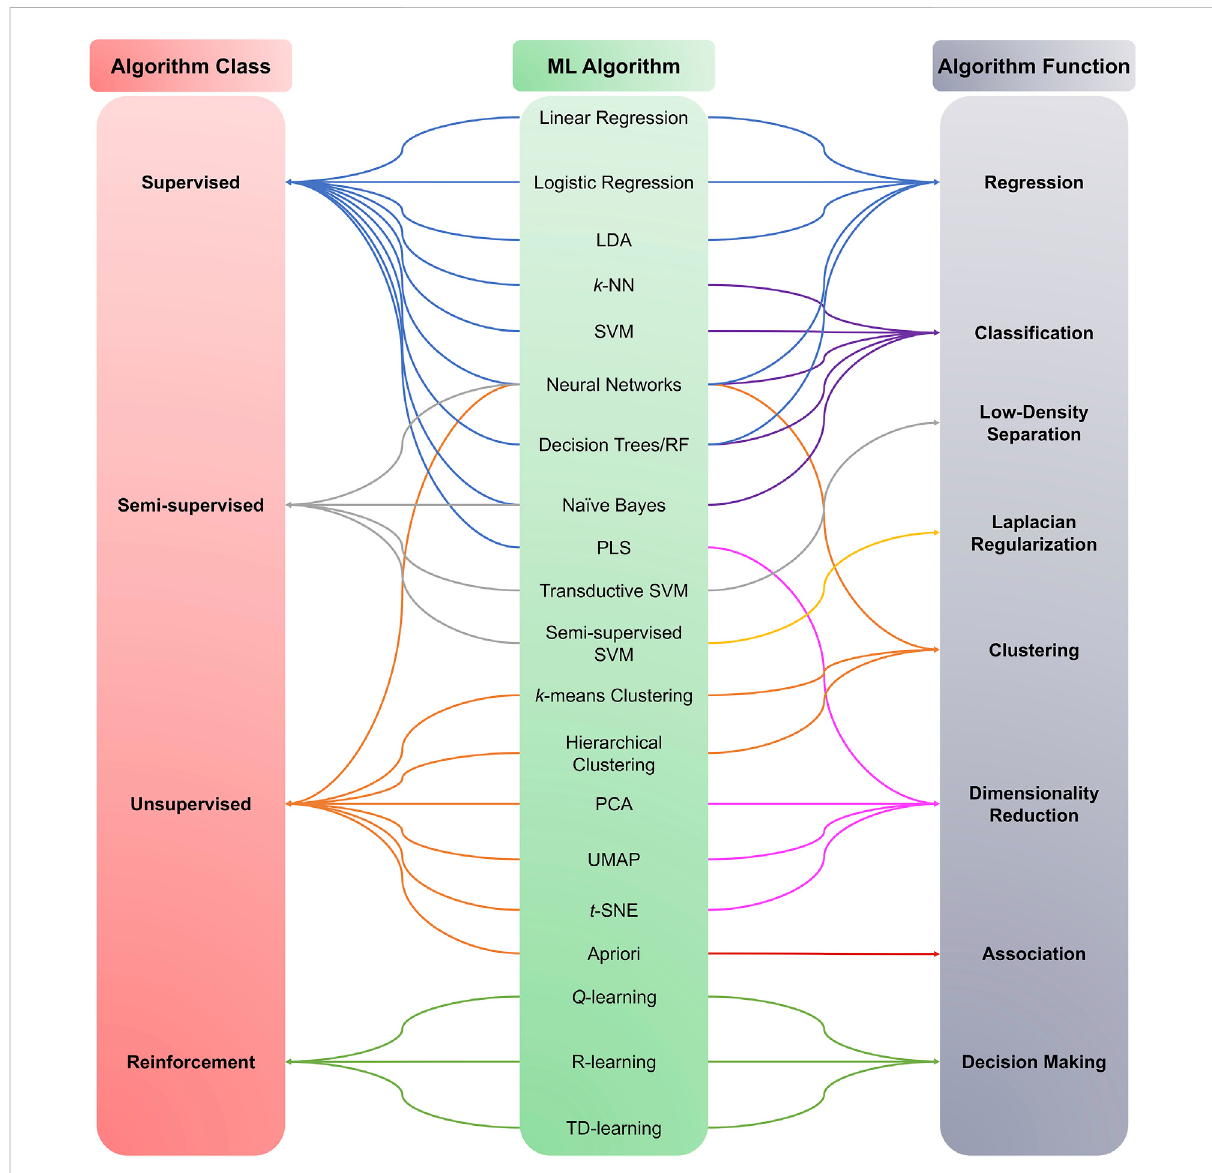
FIGURE 3 Machine learning algorithms categories. ML algorithms are divided into four main classes: Supervised, Unsupervised, Semi-supervised, and Reinforcement learning. The category choice depends on the type and nature of the data under investigation, i.e., labeled or unlabelled